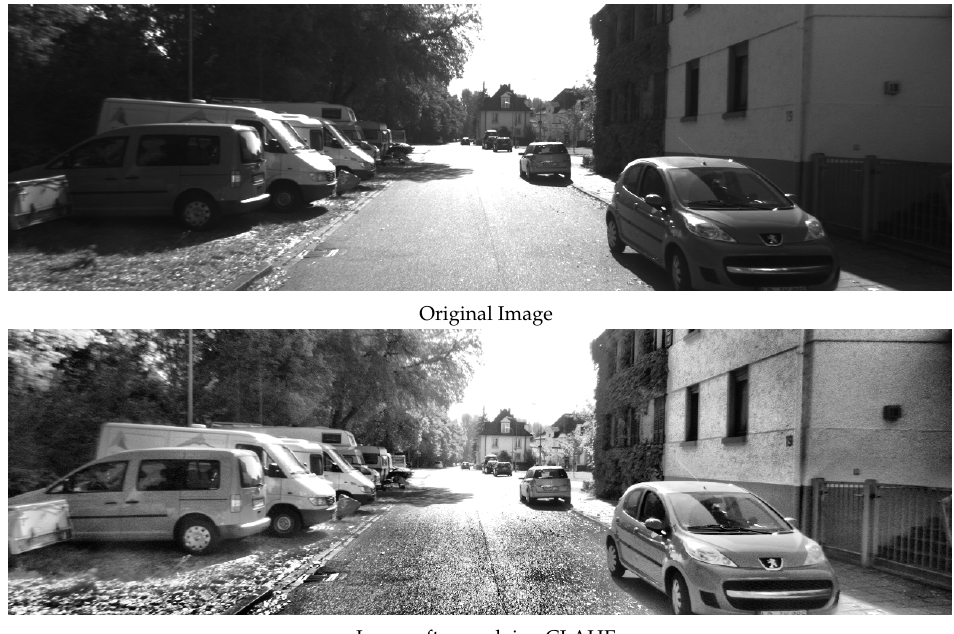
Figure 2. The effect of CLAHE filter on the image. Top: the image before applying CLAHE, Bottom: the image after applying the CLAHE algorithm with the adaptive thresholding. The image was taken from the KITTI